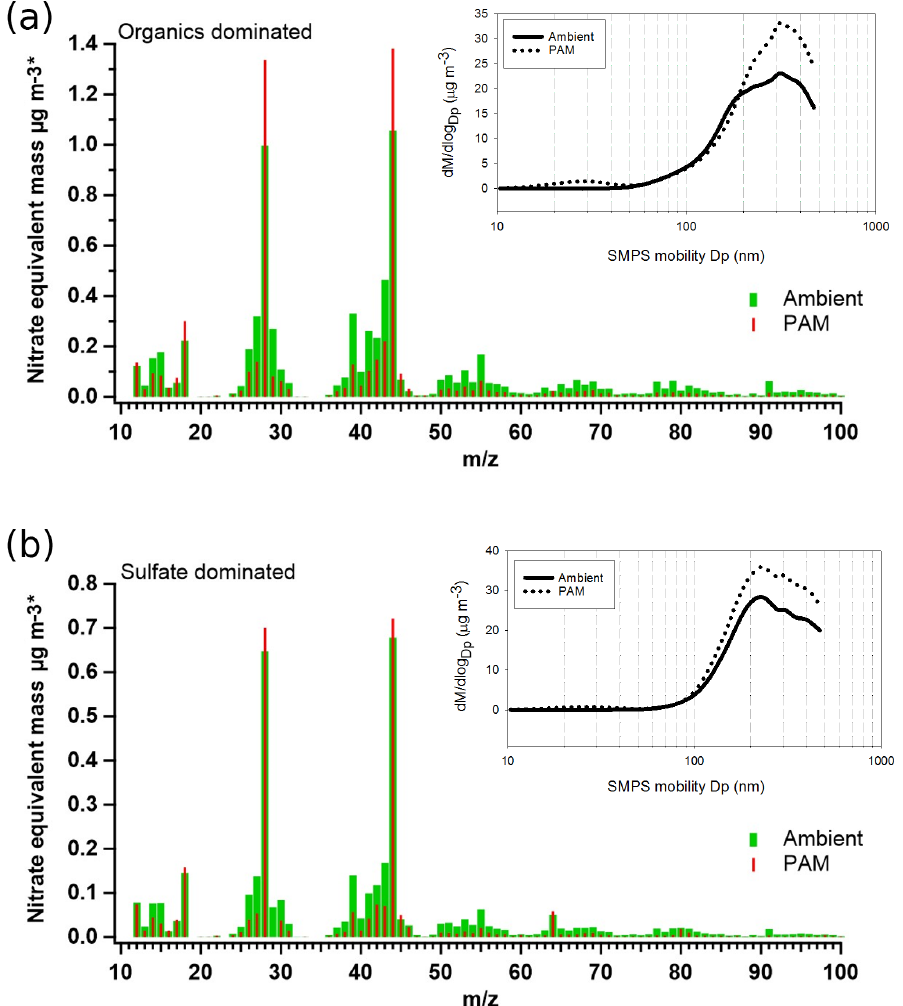
Figure 5. (a) AMS mass spectra of organics and SMPS mass size distribution averaged for the organics-dominated episode and (b) AMS mass spectra of organics and SMPS mass size distribution averaged for the sulfate-dominated